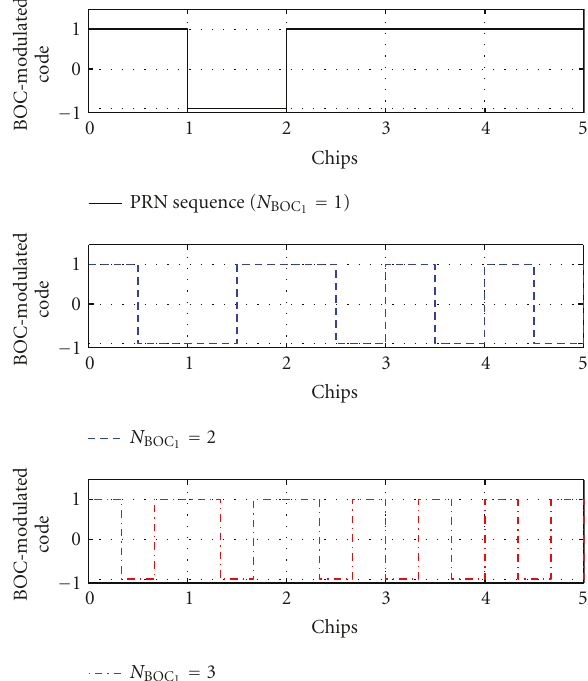
Figure 1: Examples of time-domain waveforms for sine BOC- modulated